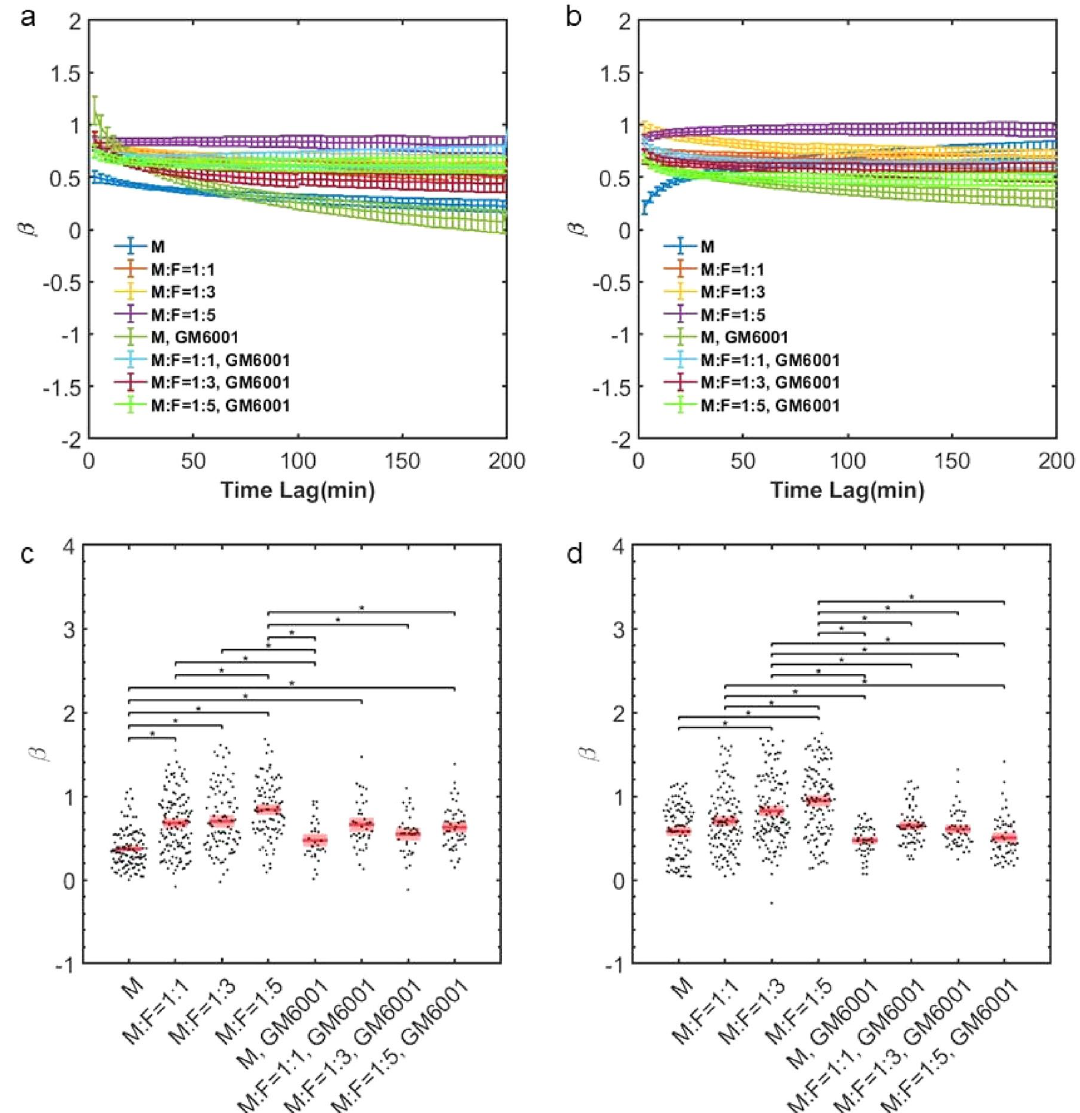
Figure 5. MDA-MB-231s migrate with altered diffusivity in the presence of NHLFs. ( a ) Average beta on day0, error bar in SEM. ( b ) Average β on day1, error bar in SEM. ( c ) β taken at the 90 min time interval, day 0. ( d ) β taken at the 90 min time interval, day 1. M indicates MDA-MB-231, and F indicates NHLF. The ratio indicates the initial seeding concentration ratio of MDA-MB-231 to NHLF cells. Red line indicates the mean value and pink boxes indicate the 95% confidence interval. One way ANOVA was performed to show the difference across all conditions. * indicates the two compared conditions are significantly different ( p < 0.05). Histogram data are shown in supplementary information SI Fig. 4. In each condition, around 50–120 cells were tracked. Data were collected from at least 3 independent experiments with 2 replicates sampled in each